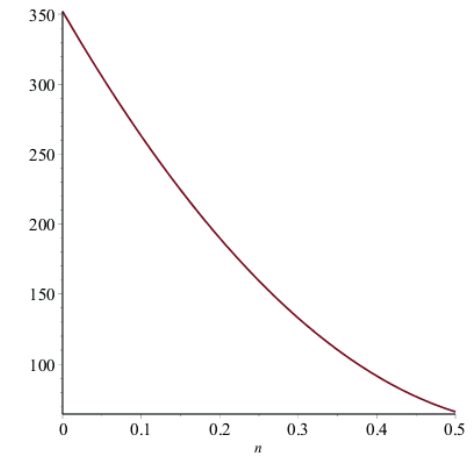
Figure 28: Plot of R